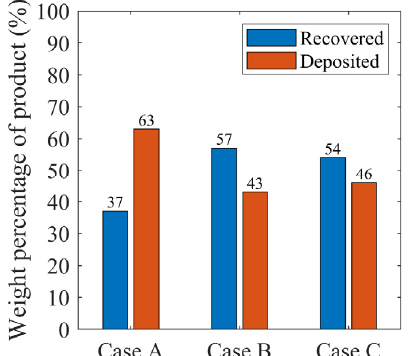
Figure 9. Product recovery at outlet and deposition in the dryer for cases A, B, and C.